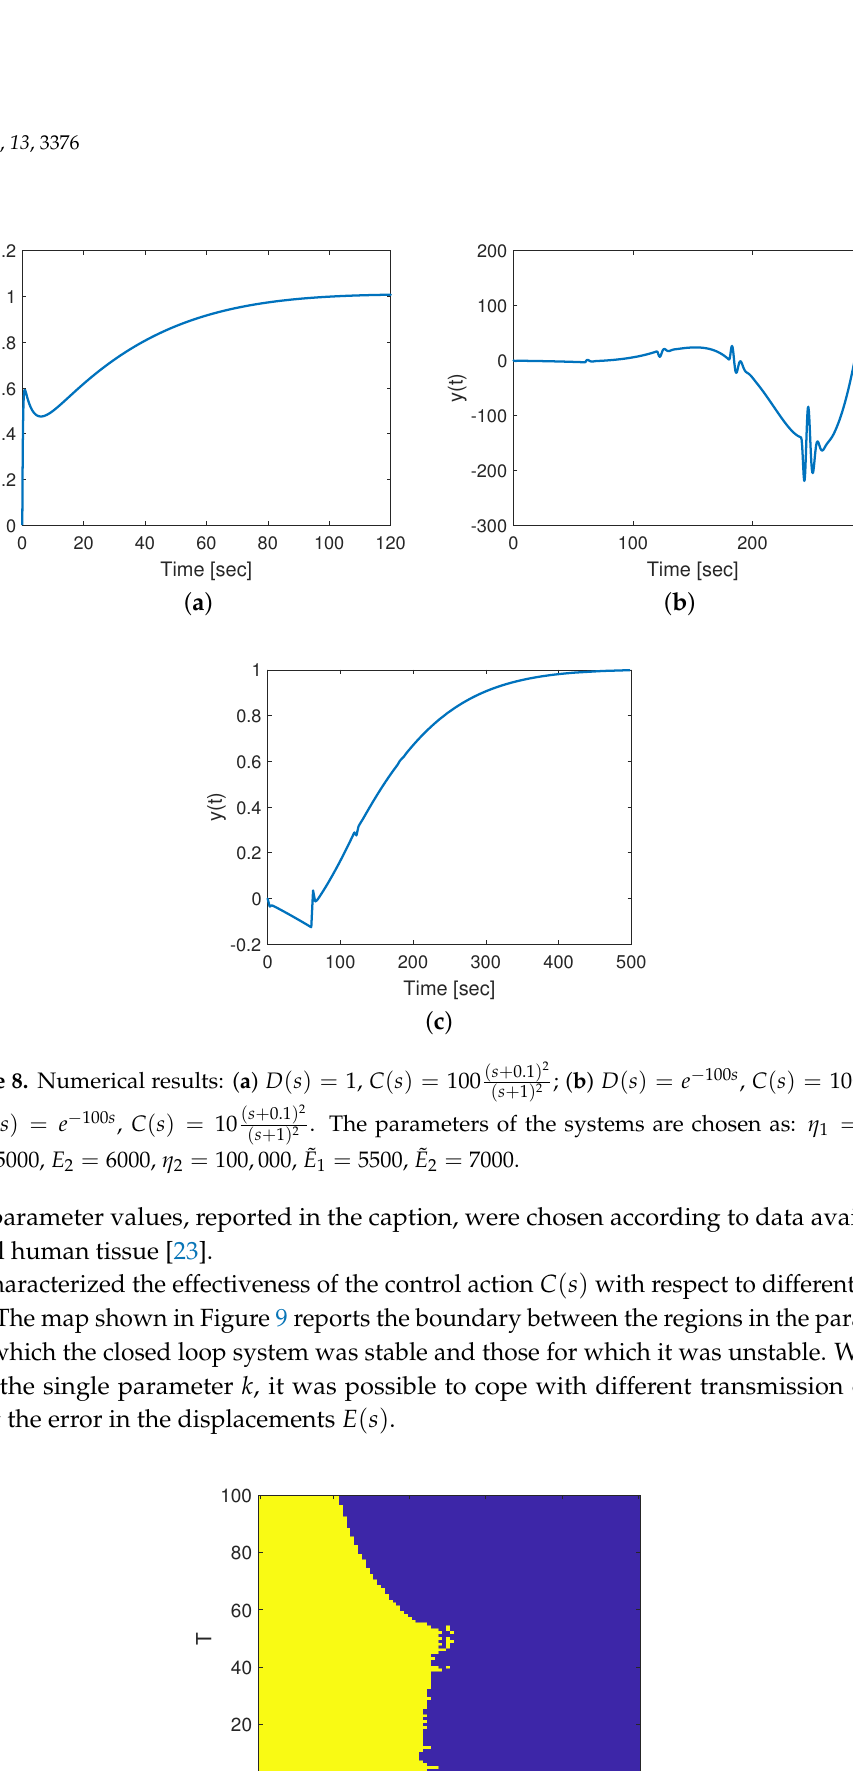
Figure 9. Boundary in the parameter space k − T between the stability (yellow) and instability (blue) regions, for z = 0.1. Other parameters as reported in the caption of Figure